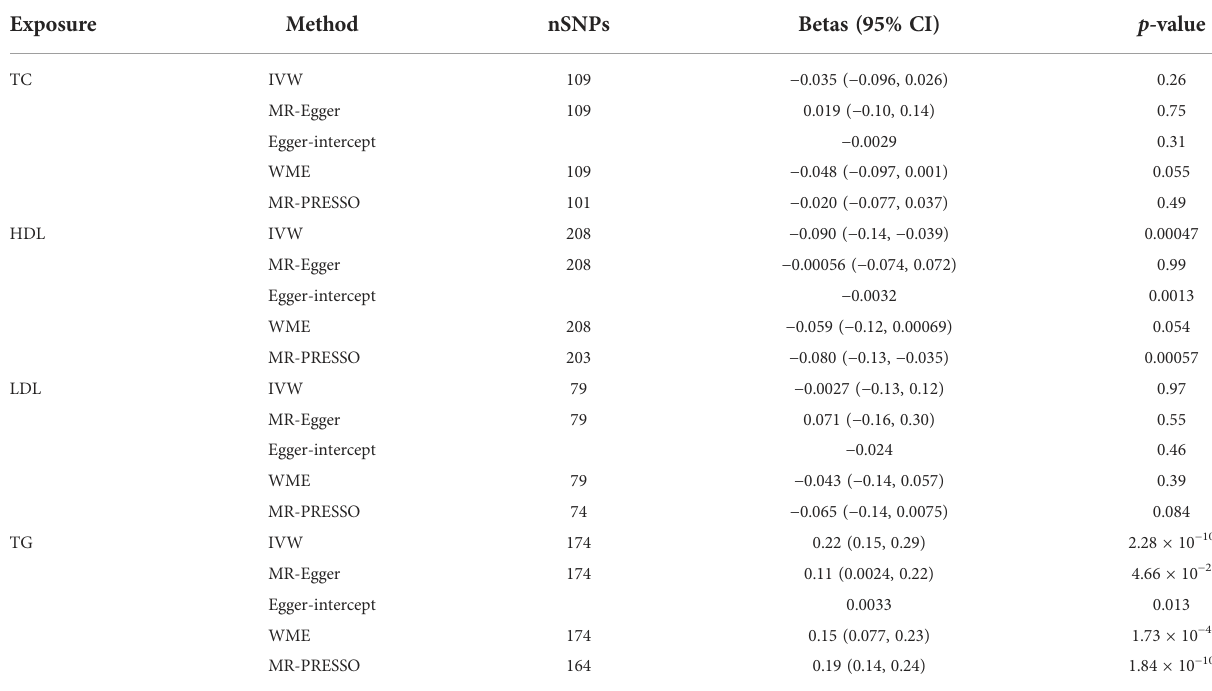
TABLE 5 Effect of lipid traits on serum urate.